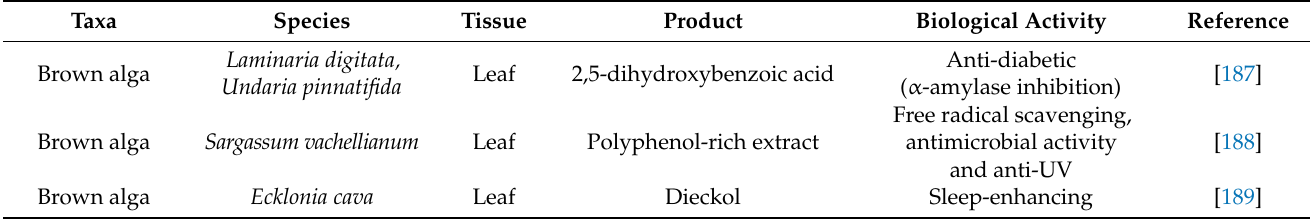
Table 7. Phenols from seafood wastes, together with taxa, species and tissue from which they were isolated, and their biotechnological